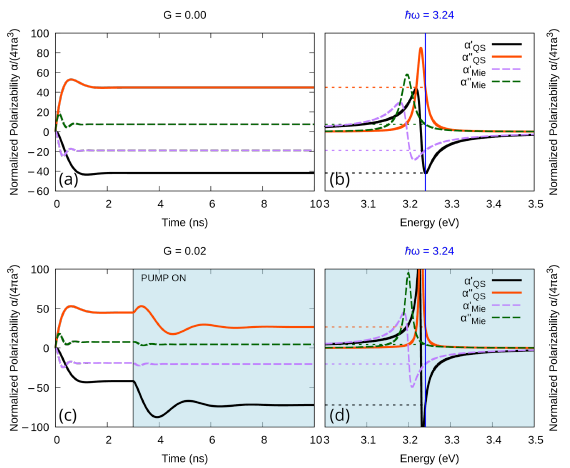
Figure 2. Real and imaginary part of the Polarizability of a silver nanoparticle of radius 60 nm in water enriched with a gain medium with emission central frequency ¯ h ω 21 = 3.23 eV and emission width ∆ = 0.15 eV. ( a , b ): No gain is added to the system. ( c , d ): Some gain is included, but the system remains sub-emissive ( G = 0.5 · G th ). ( a , c ): Time dependence of the polarizability for a single frequency; ( b , d ): corresponding steady state